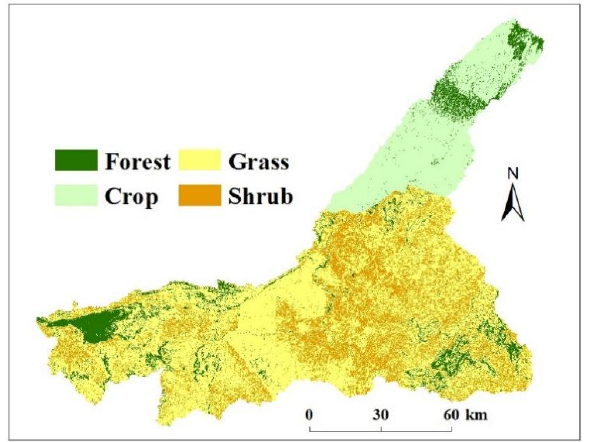
Figure 3. Vegetation distribution map of Mara River Basin.